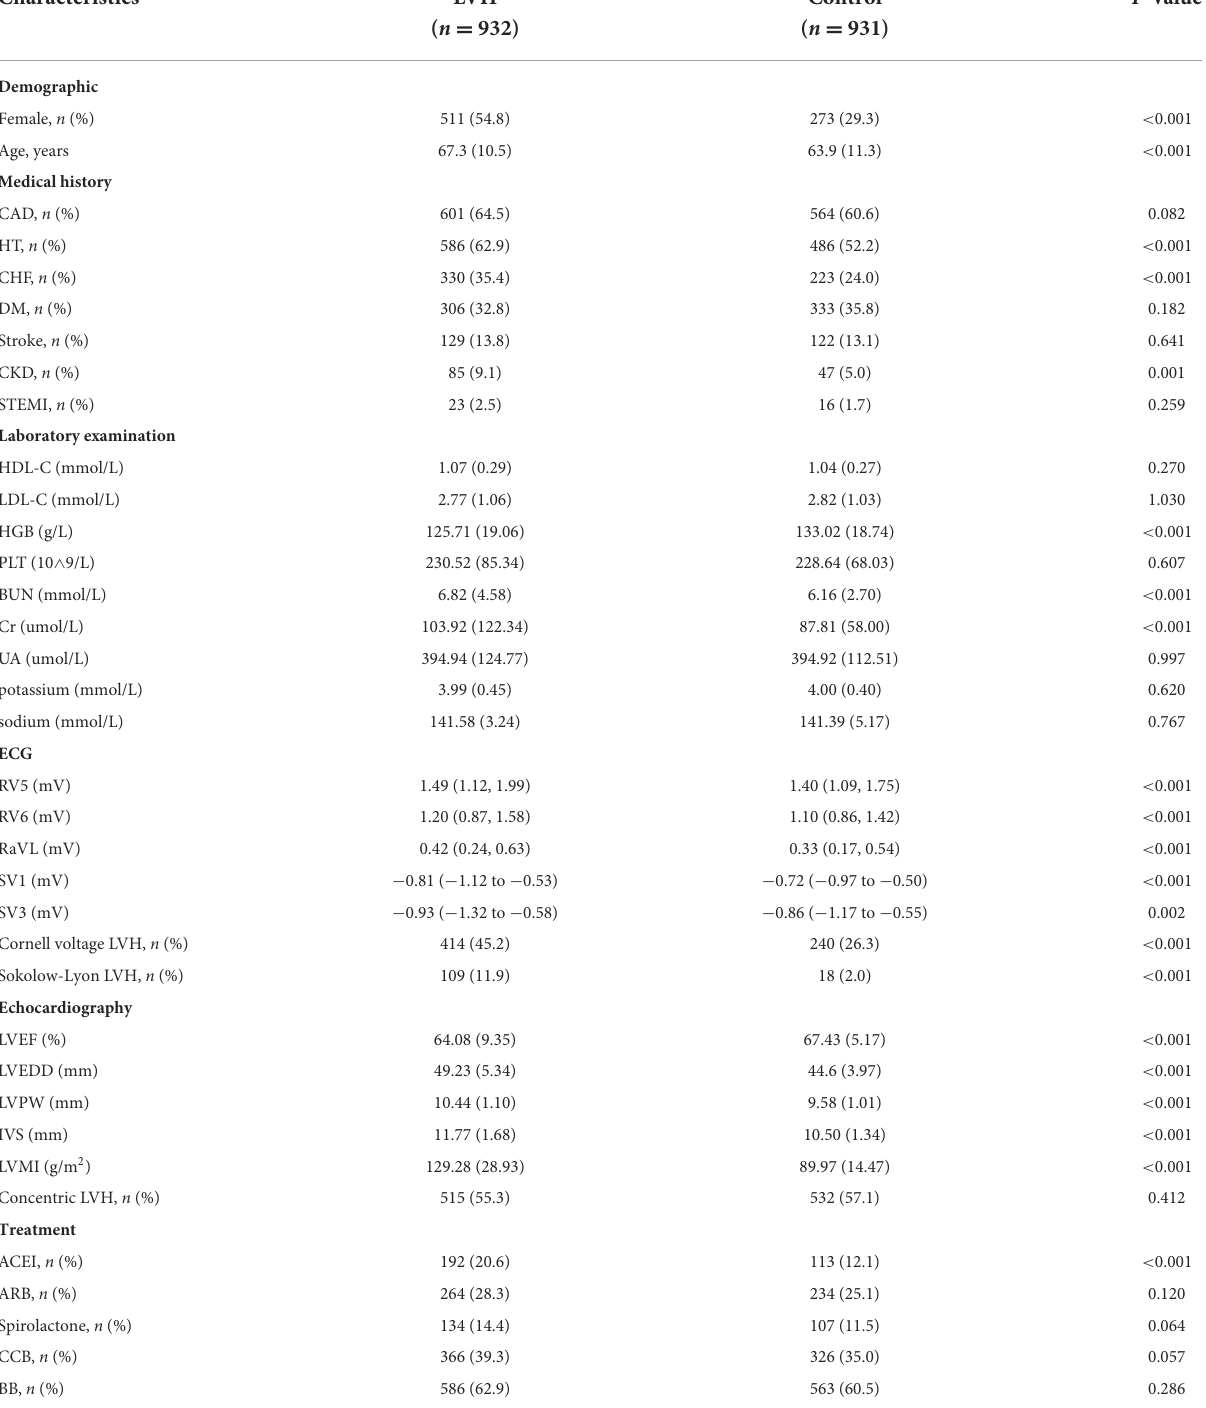
TABLE 1 Patient characteristics between LVH and control groups.